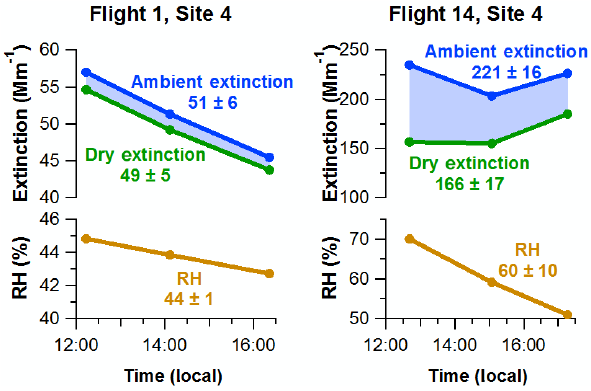
Figure 12. Trends in 532nm ambient extinction, dry extinction, and RH below 1km during spirals at site 4 during flights 1 and